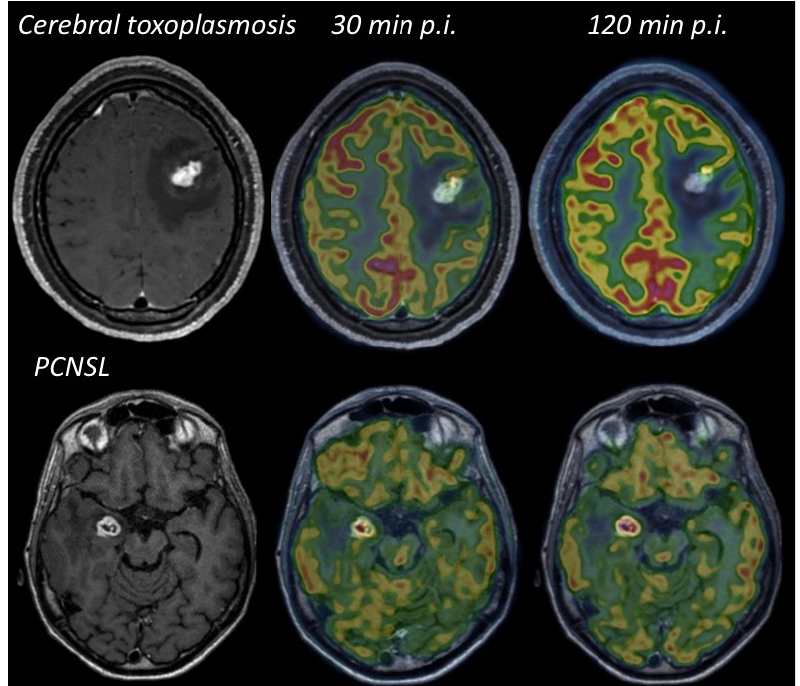
Figure 5. Illustrative case of the value of delayed acquisition of 18 F-FDG PET to differentiate infection from malignancy in an IS patient. The first patient was a 19-year-old female with AIDS disease, while the second patient was undergoing immunosuppressive therapy for renal transplantation. The 18 F-FDG PET scan was performed for both patients at 30 and 120 min after injection (p.i.). In the first case, tracer uptake was very low at 30 min p.i. and decreased with time (SUVmax = 4.7 and 3.2; T/N = 0.3 and 0.2). The patient was diagnosed with cerebral toxoplasmosis by serological evaluation. In the second case, the lesion showed a progressive increase in metabolic activity over time compared with normal tissue (SUVmax = 5.9 and 11.2; T/N = 1.5 and 1.7) and brain biopsy confirmed brain